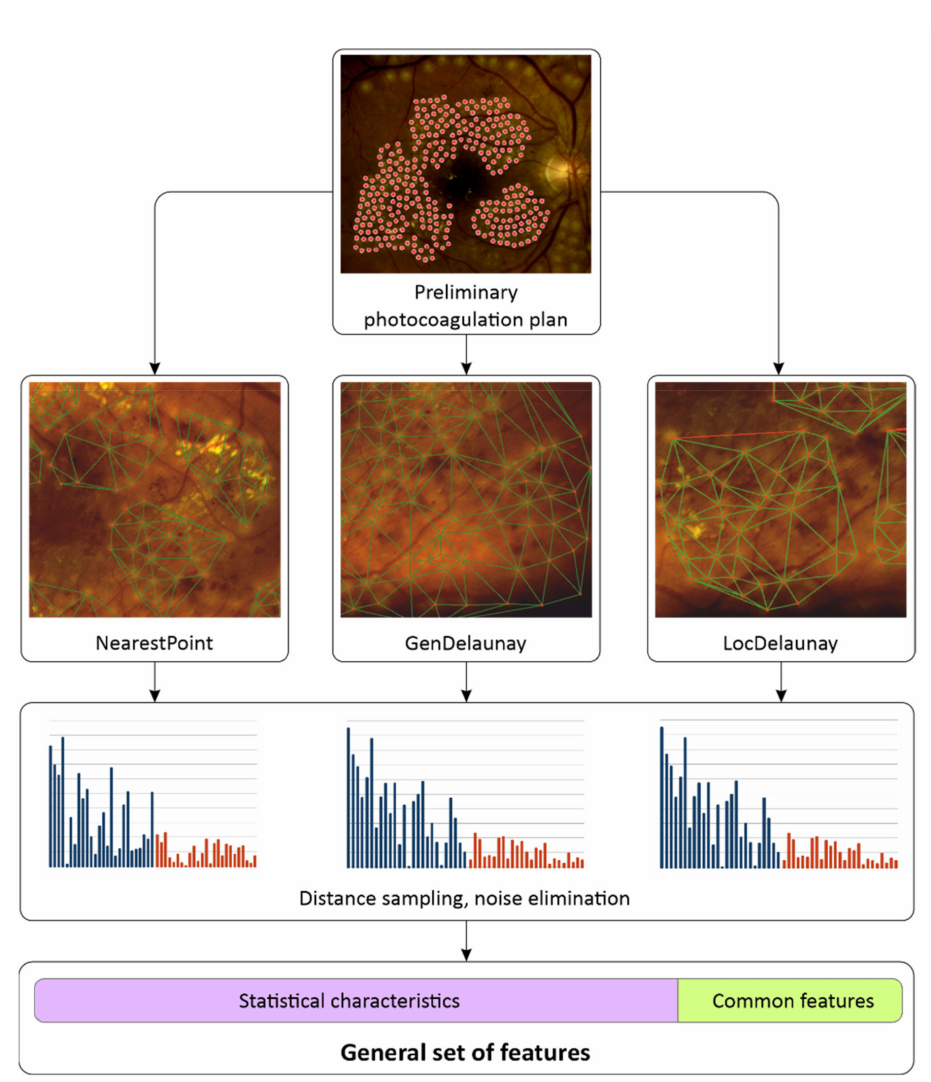
Figure 4. Scheme for the computation of features for a photocoagulation plan. Each of the features presented allows the degree of a particular prognostic factor to be described. Table 3 shows the main prognostic factors and their corresponding